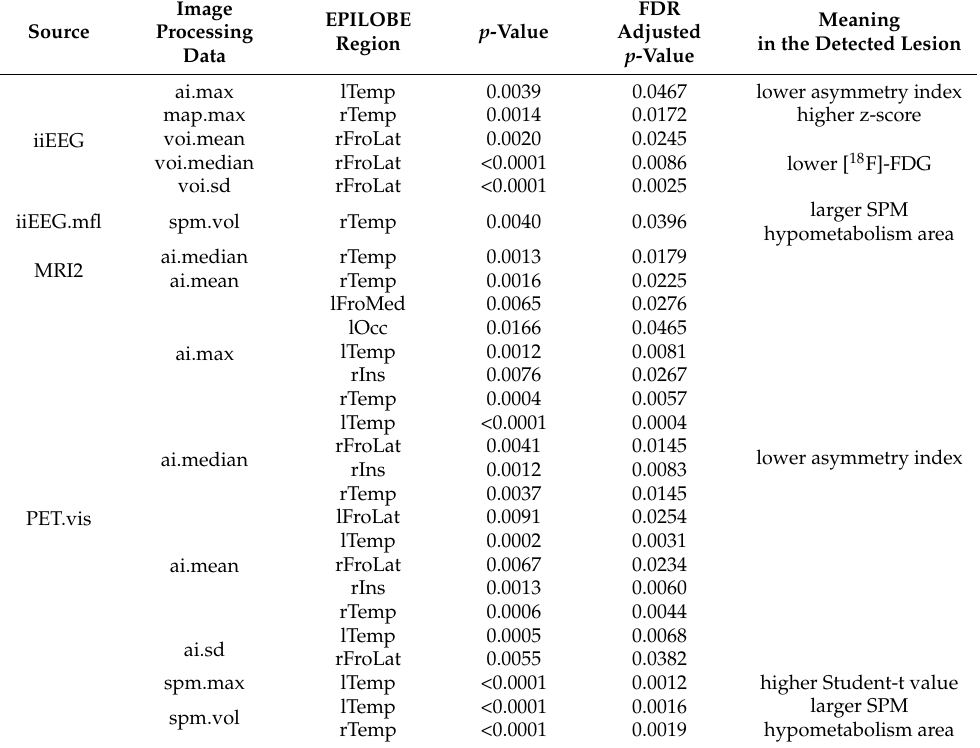
Table 4. Association between interictal EEG, MRI2, and [ 18 F]-FDG PET localization, and [ 18 F]-FDG PET image processing data (performed by pairwise Wilcoxon test with FDR adjustment) l: left; r: right; FroMed: frontomedial; FroLat: frontolateral; FroCent: frontocentral; Temp: temporal; Par: parietal; Occ: occipital; Ins: insular. Image EPILOBE p -Value Source Processing Region Data